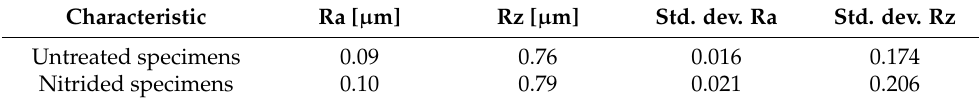
Figure 2. Technical drawing of the finished ground and polished specimen. Table 3. Roughness parameters measured on the calibrated zone of samples.